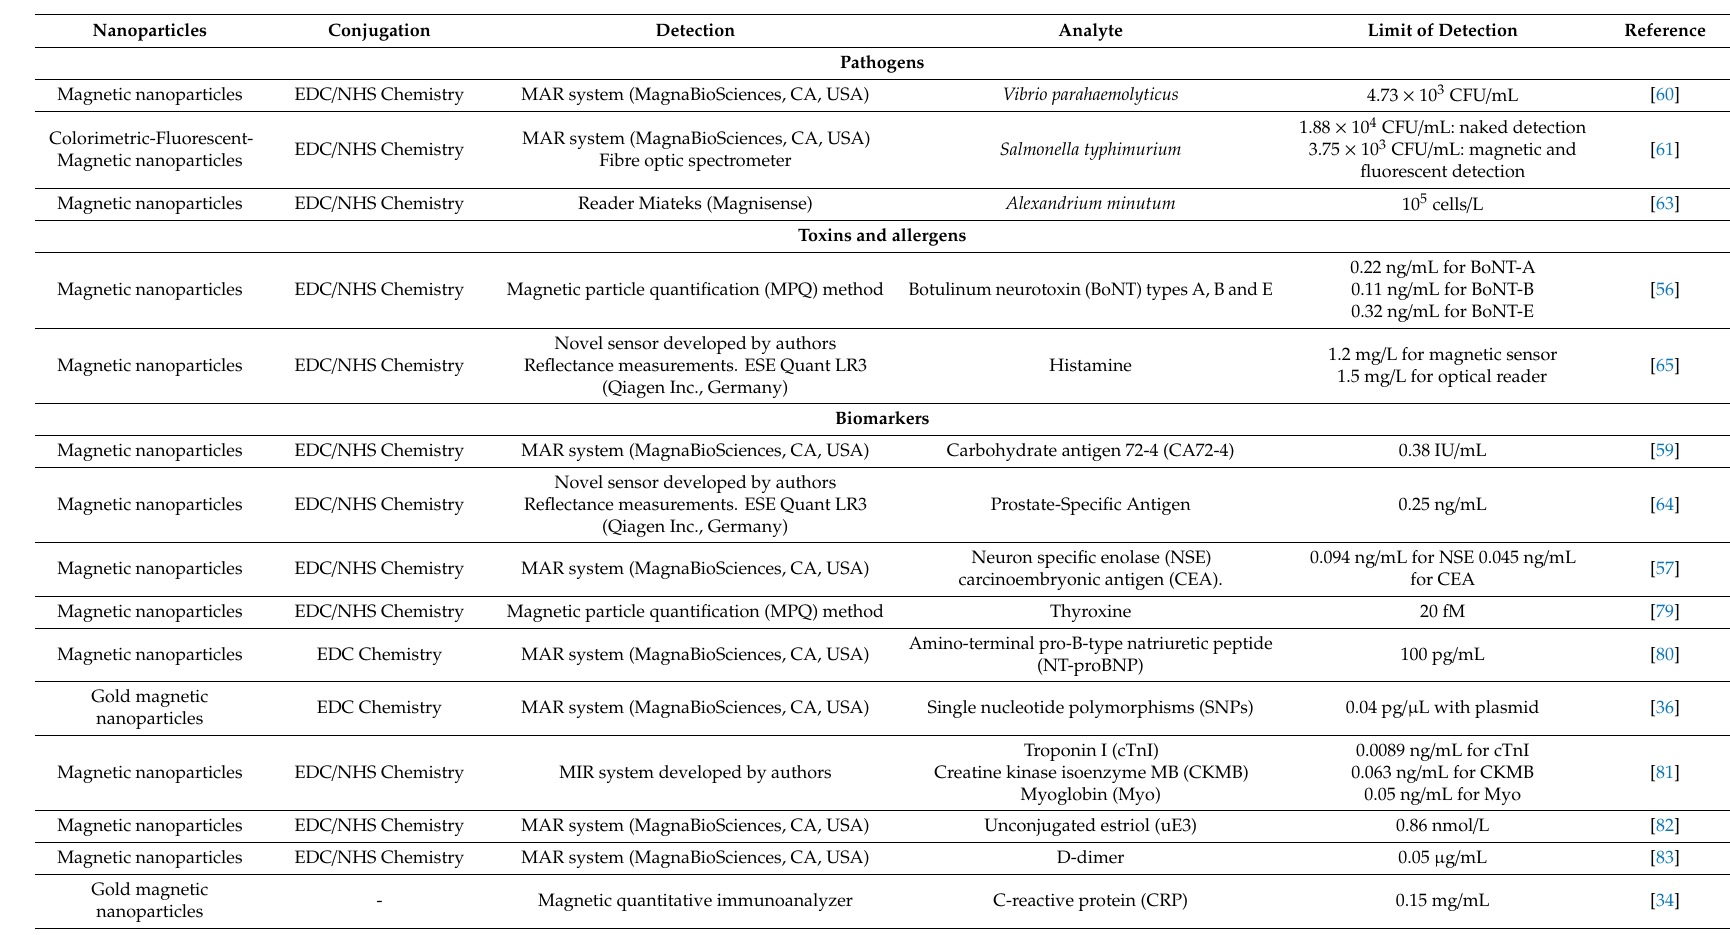
Table 4. Most recent Magnetic LFIA with magnetic